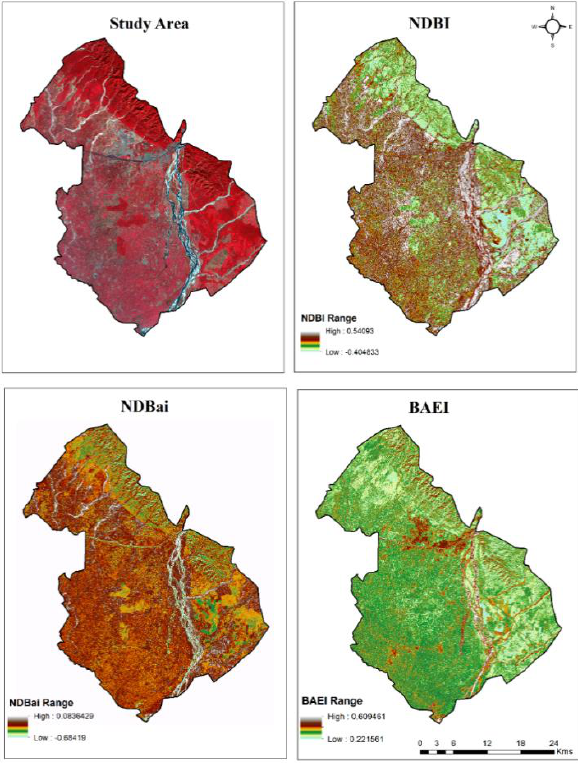
Figure 4. (a) Original OLI image (b) NDBI (c) NDBai (d)